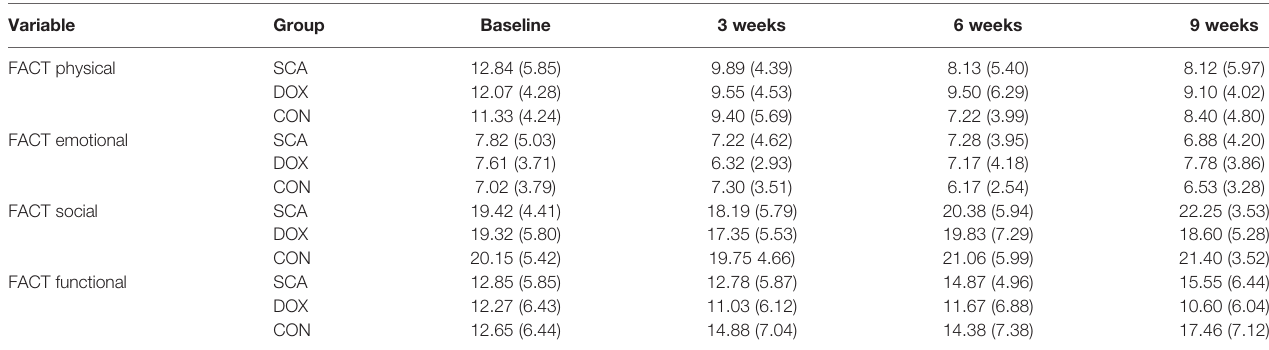
TABLE 3 | FACT-L score in three groups before and after treatment. Variable